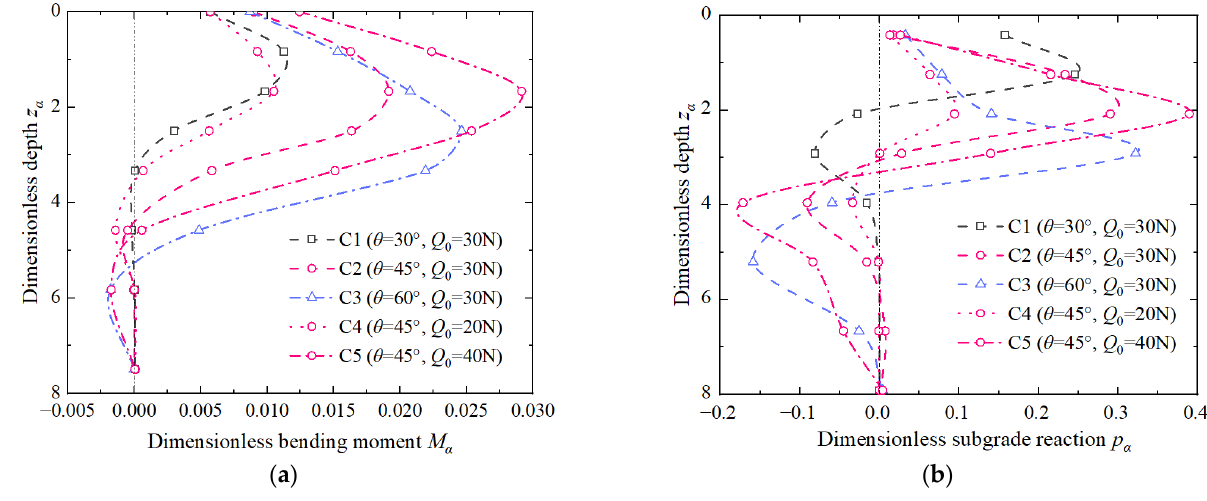
Figure 14. Dimensionless bending moment and subgrade reaction profiles under different slope angles and load amplitudes. ( a ) bending moment profiles; ( b ) subgrade reaction profiles.